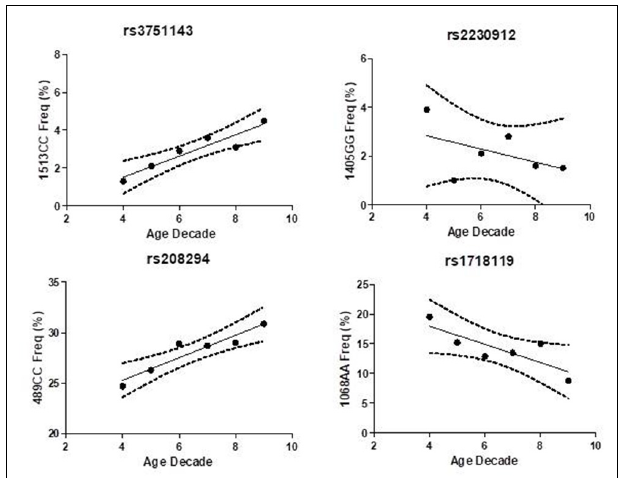
FIGURE 2 | Association of P2X7 genotypes frequency with age decade in Caucasian control